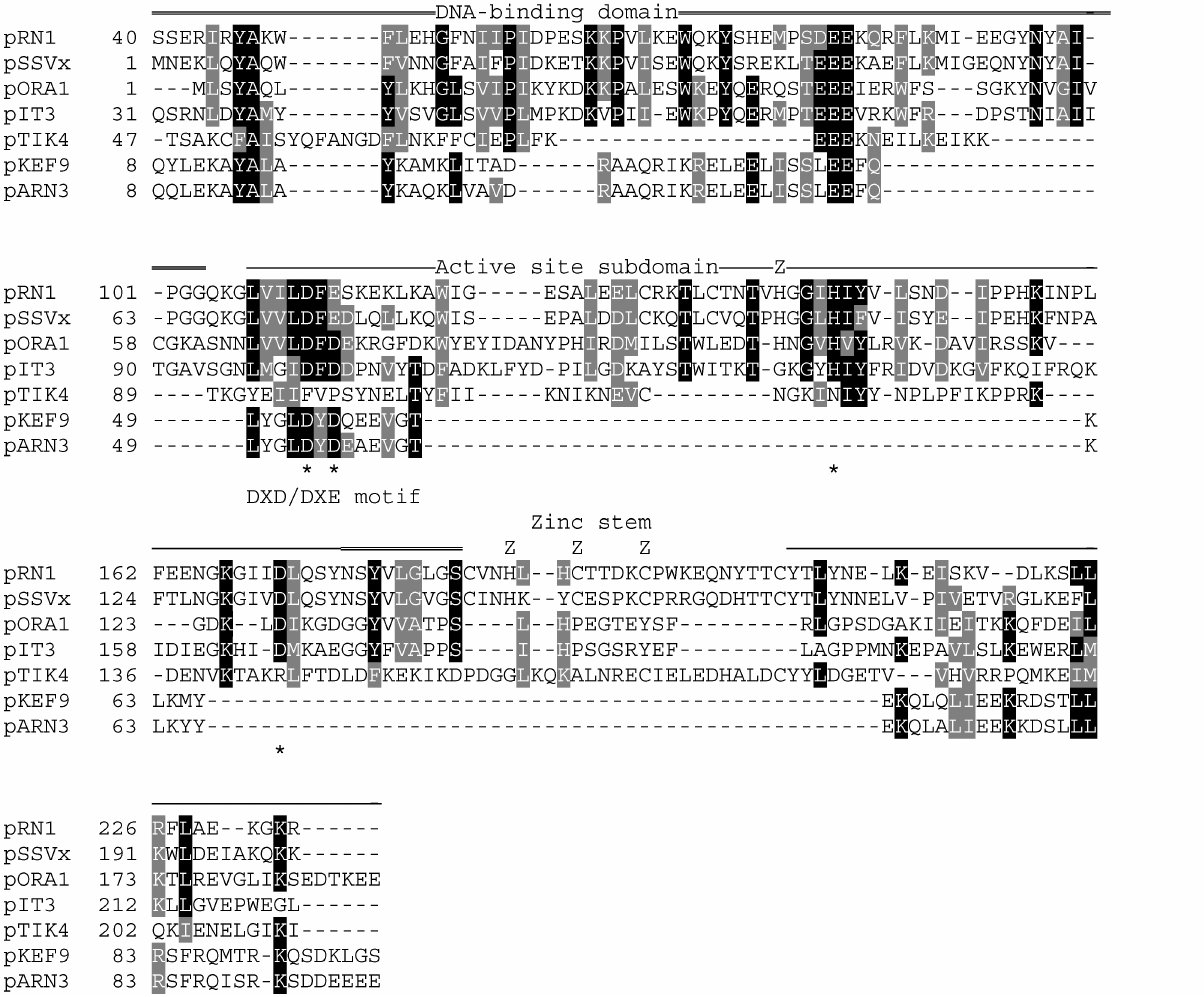
Figure 2. Alignments of the N-terminal regions of RepA homologs from the Sulfolobus cryptic plasmids pRN1, pSSVx, pORA1, pIT3 and pTIK4 and the conjugative plasmids pKEF9 and pARN3. The double line above the alignment denotes the DNA-binding domain and the single line de- lineates the active site subdomain. Functionally important amino acids in the latter are indicated by asterisks, and the DXD/DXE motif is shown (Lipps 2003, Lipps et al. 2004). Amino acids involved in the zinc-bindingstem are denoted by Z. The sequence of putative RepA homolog of pIT3 is from GenBank accession no. AY591755 (H.-P. Klenk, e-Gene Biotechnologie GmbH, Feldafing, Germany, unpublished data). Alignments of identical and similar amino acids are indicated by black and gray boxes, respectively, obtained with Boxshade